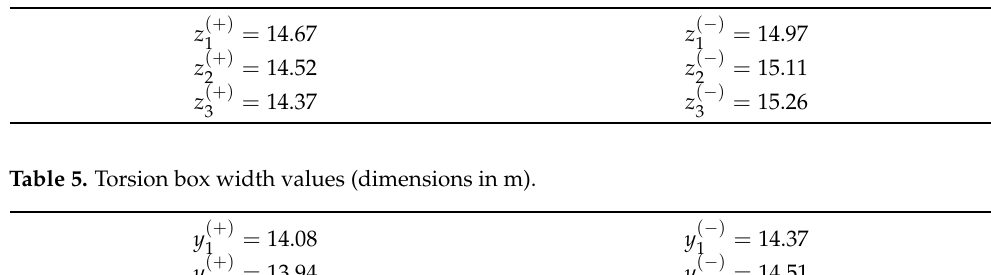
Table 4. Torsion box height values (dimensions in m).